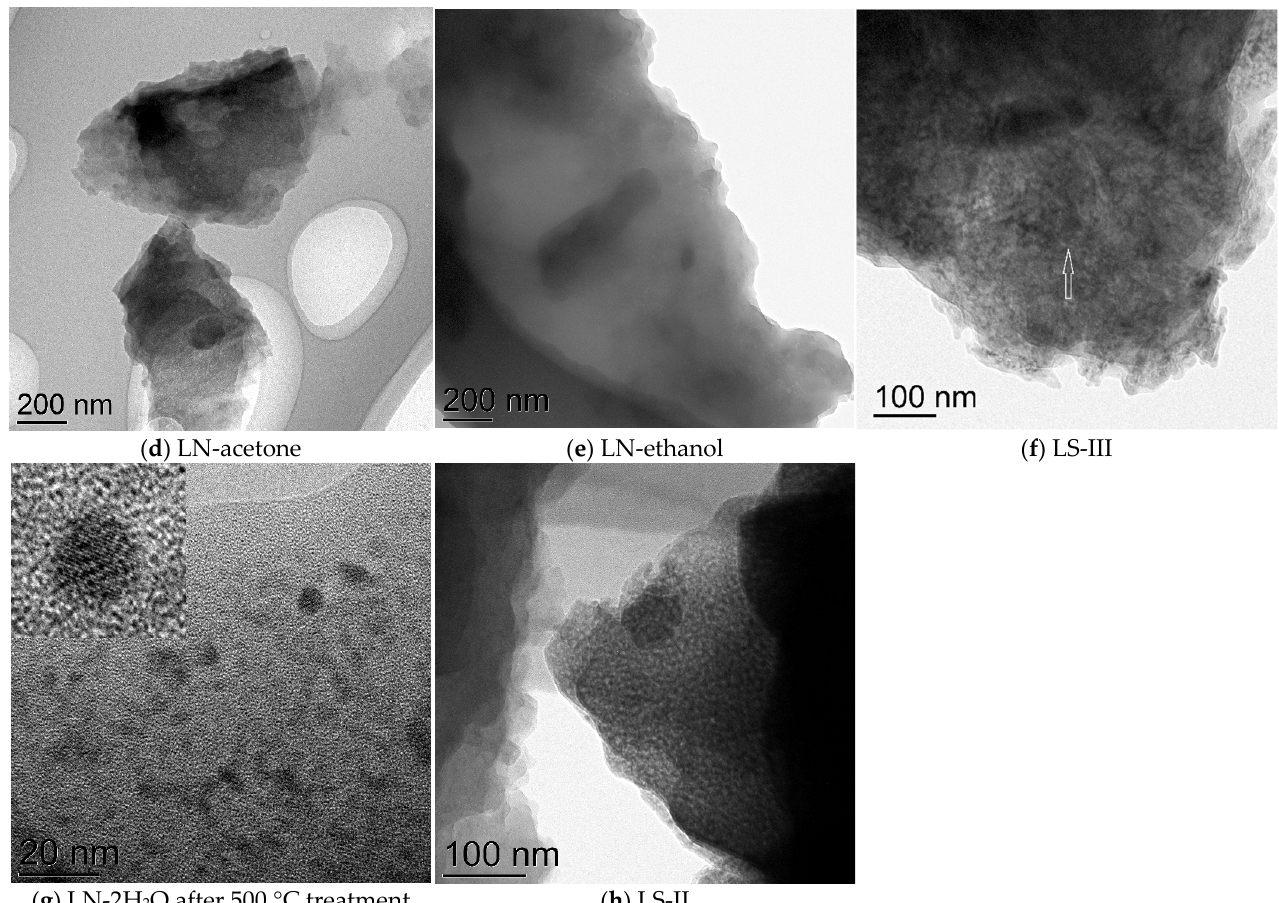
Figure 2. TEM images for the prepared materials under the chosen synthesis conditions and the sample LN-2H 2 O after 500 ° C treatment.